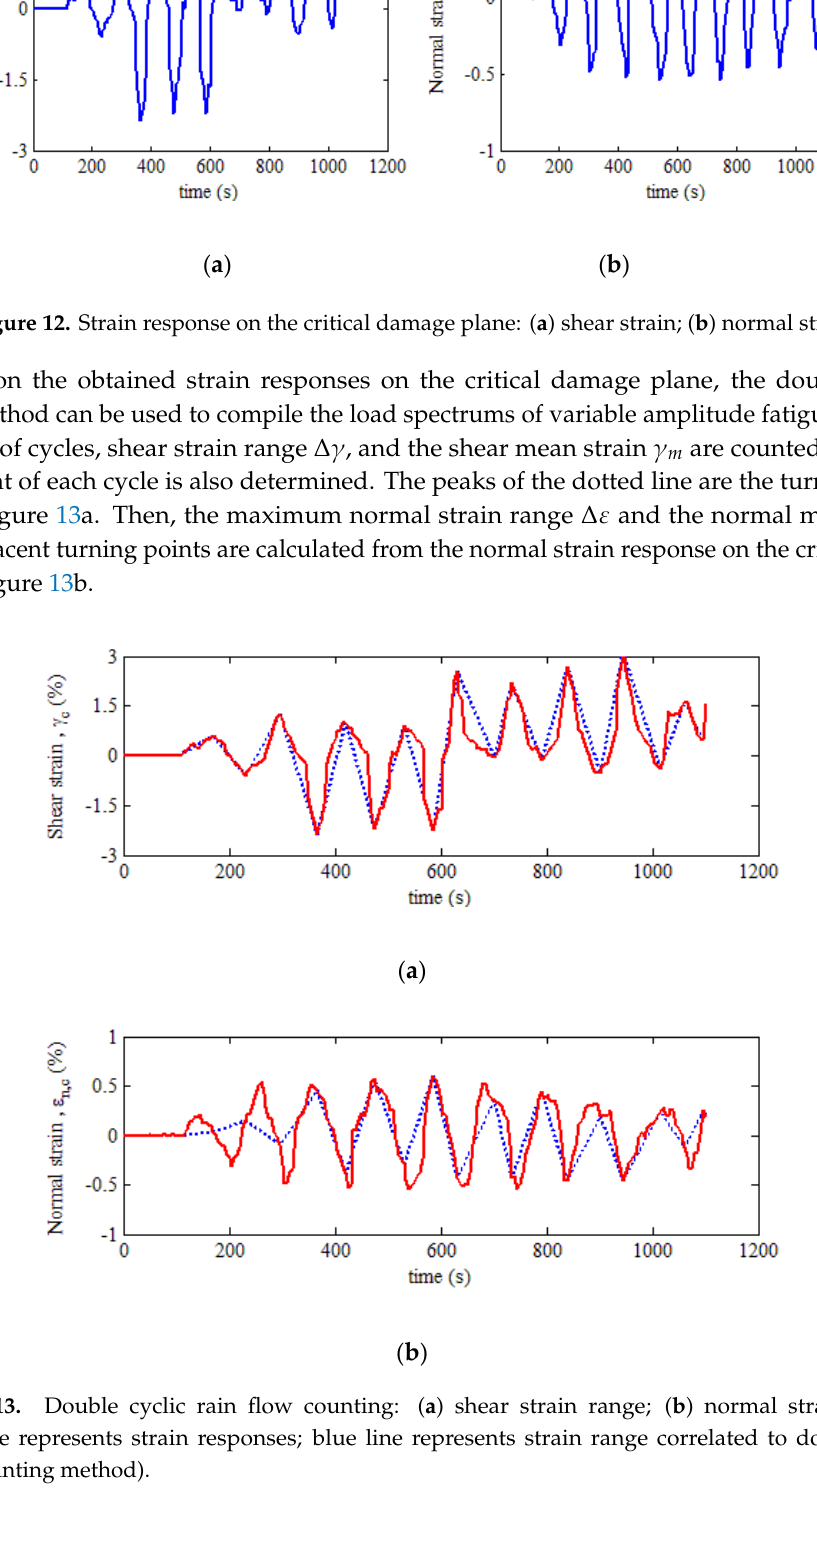
Figure 13. Double cyclic rain flow counting: ( a ) shear strain range; ( b ) normal strain range. (Red line represents strain responses; blue line represents strain range correlated to double rain flow counting